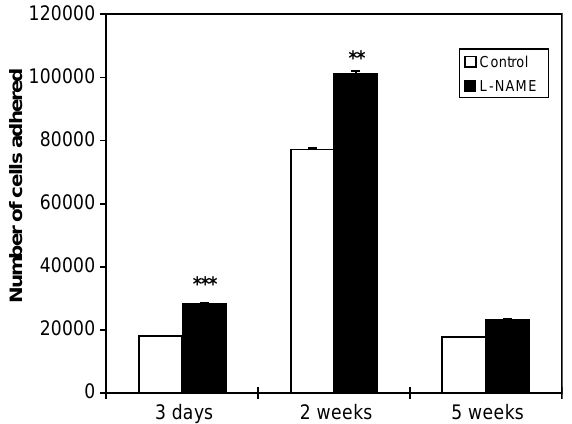
FIG. 3. Adhesion of peritoneal macrophages taken from control and L-NAME-treated rats to quiescent monolayers of rat epitenon cells. Error bars represent standard error of the means. **p B / 0.0025 and ***p B / 0.0005 versus macro- phages taken from control untreated